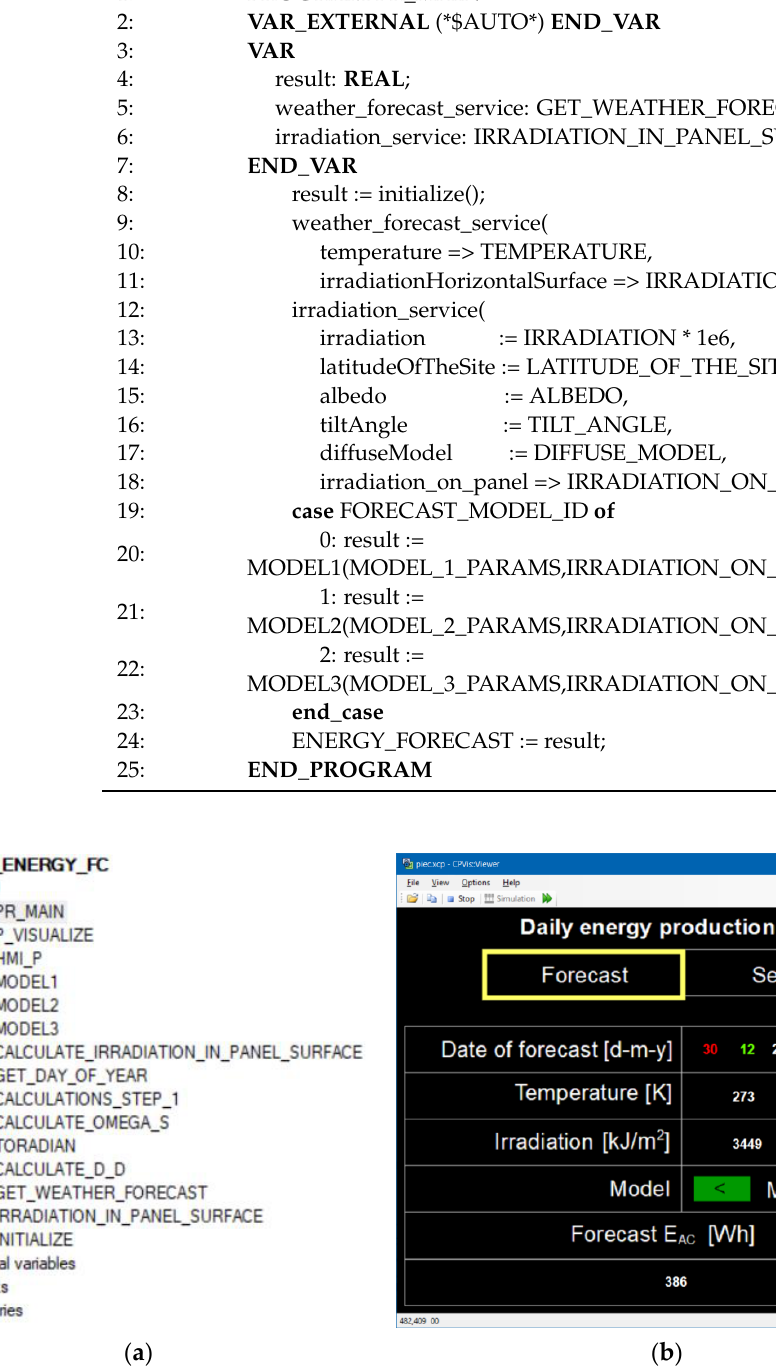
Figure 11. ( a ) Structure of the program; ( b ) the Human-Machine Interface (HMI) in the CPVis the simulation environment. Algorithm 2 The main function of the energy production forecast program.